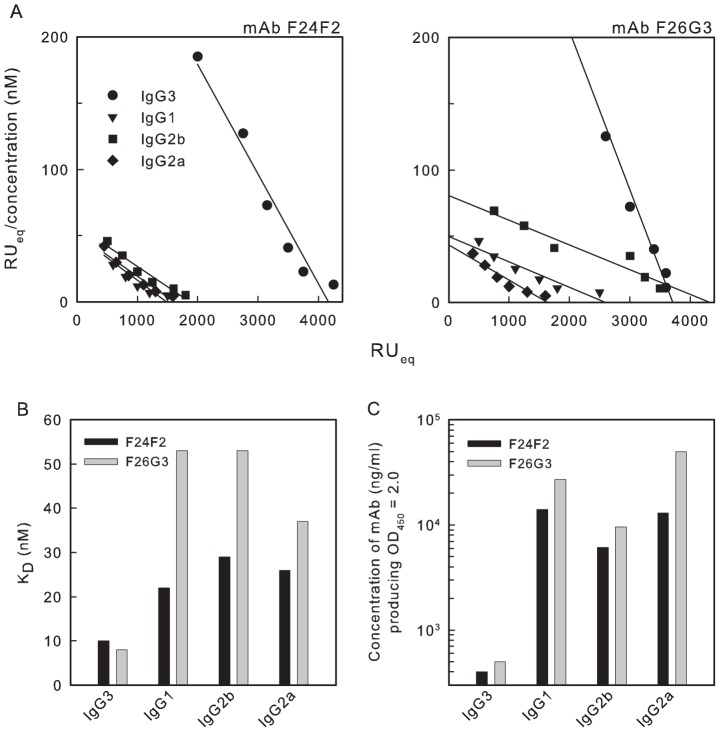
Binding of subclass switch families of mAbs F24F2 and F26G3 to γdPGA.A – Scatchard plots for determination of functional affinities from equilibrium binding. Binding was assessed by SPR using intact mAb and sensor chips coated with 25-mers of γdPGA. B – KD for binding of each mAb shown in Panel A. KA was determined from the slope of the regression lines in Panel A. KD was calculated as 1/KA. C - Binding of each mAb as assessed by ELISA in which plates were coated with purified native γdPGA. Results are reported as the concentration of each mAb (ng/ml) that produced an OD450 = 2.0 in a standard ELISA format.